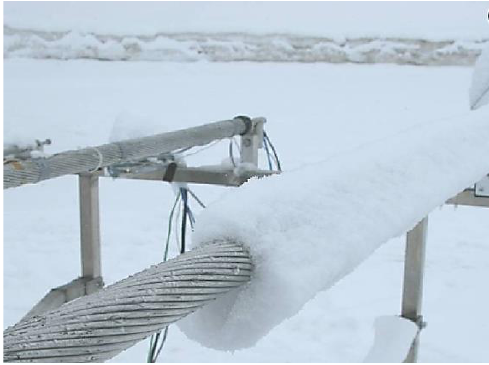
Coatings 2023 , 13 , x FOR PEER REVIEW 12 of 19 Figure 7. Snow-sleeve on the reference conductor after a snow-fall event. The anti-snow behaviour of the coated samples was always appreciable, and it mani- fested with two mechanisms: the delay in the formation of the snow-sleeve and the early detachment with respect to the reference. Example of these behaviours is reported in the Figure 8a,b, respectively.